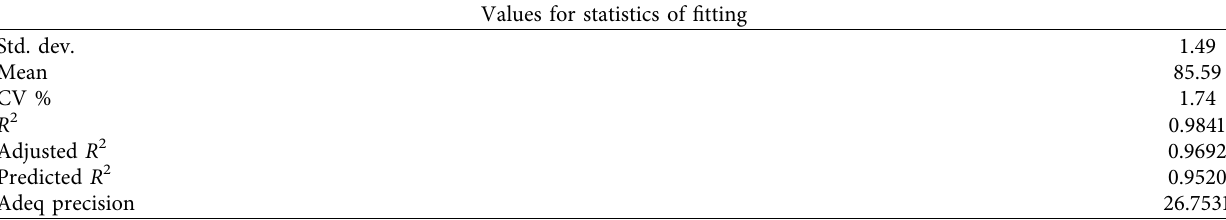
Table 5: Values for statistics of the fitting.